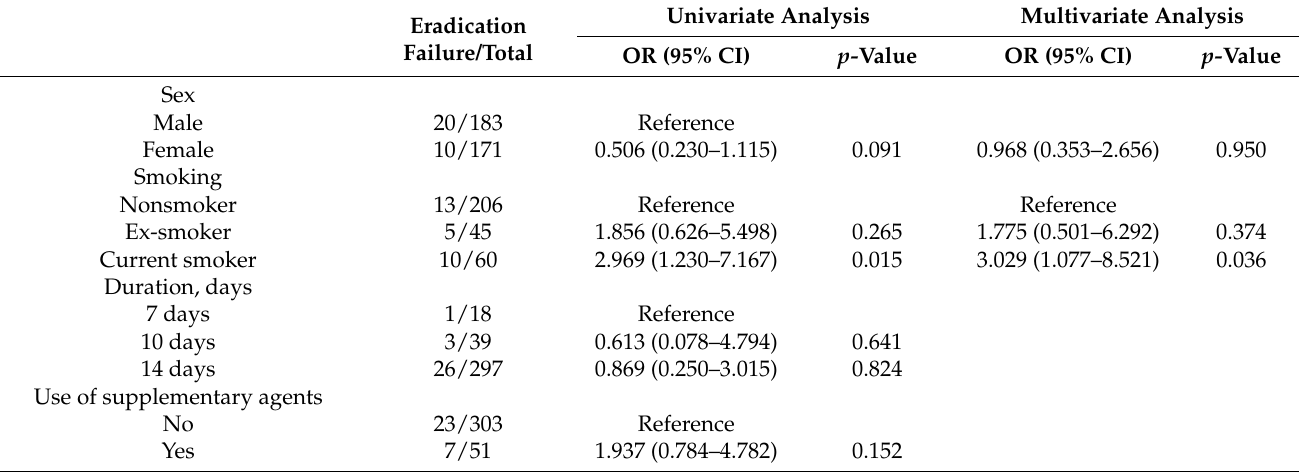
Table 3. Factors associated with eradication